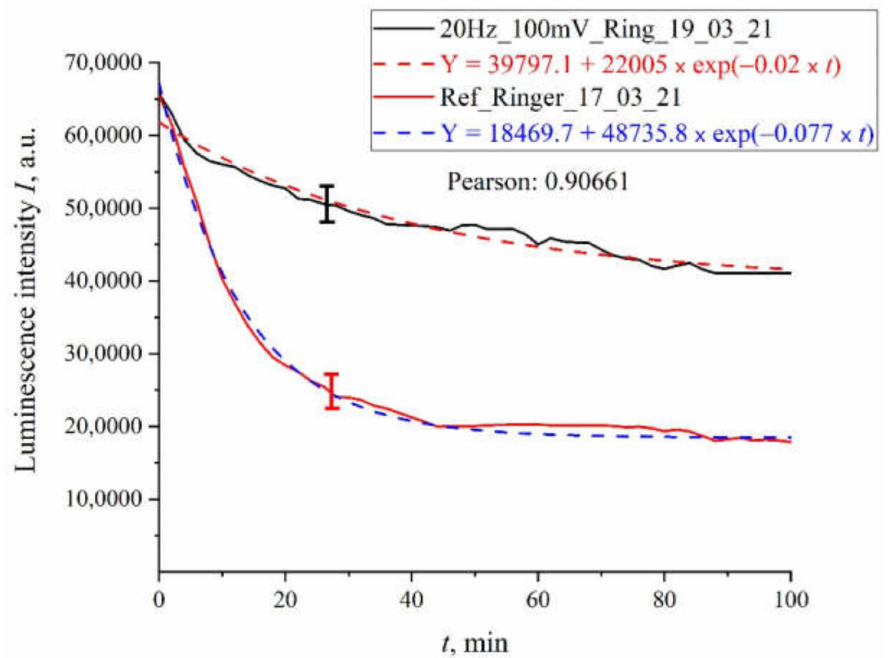
Figure 5. The results of processing with pulses of amplitude 100 mV at a repetition rate of 20 Hz: for Ringer’s solution.